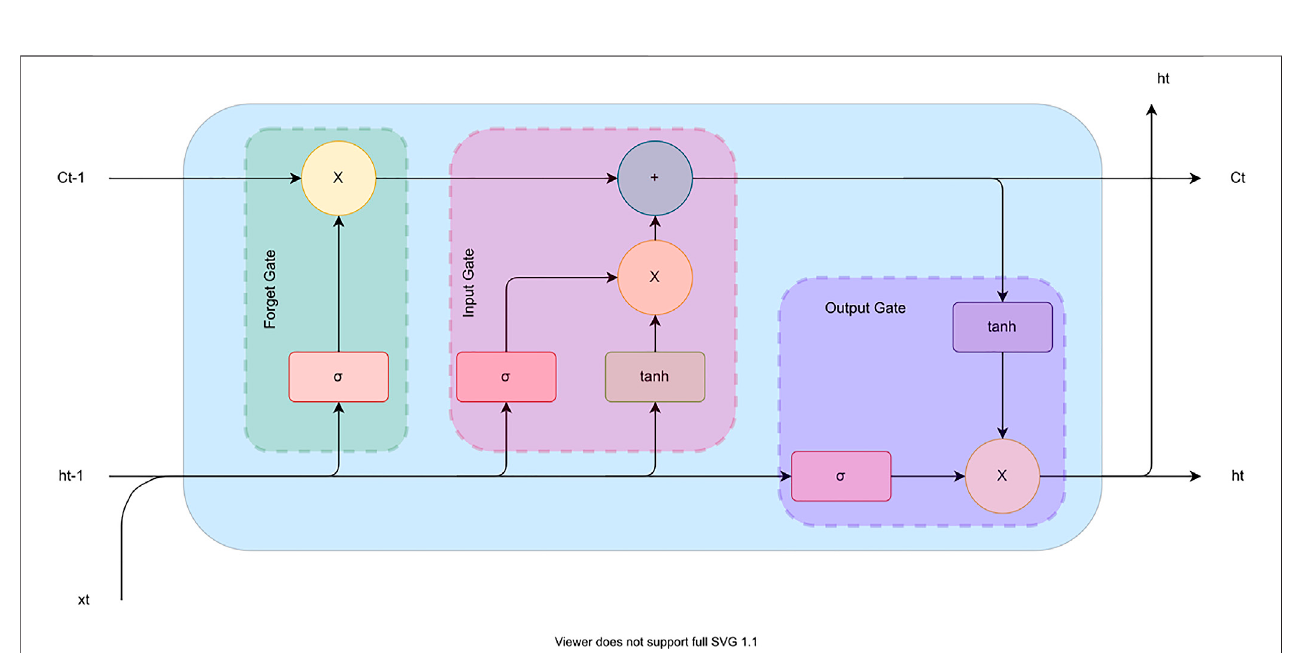
FIGURE 3 | Flow-chart of the procedure followed in training models.